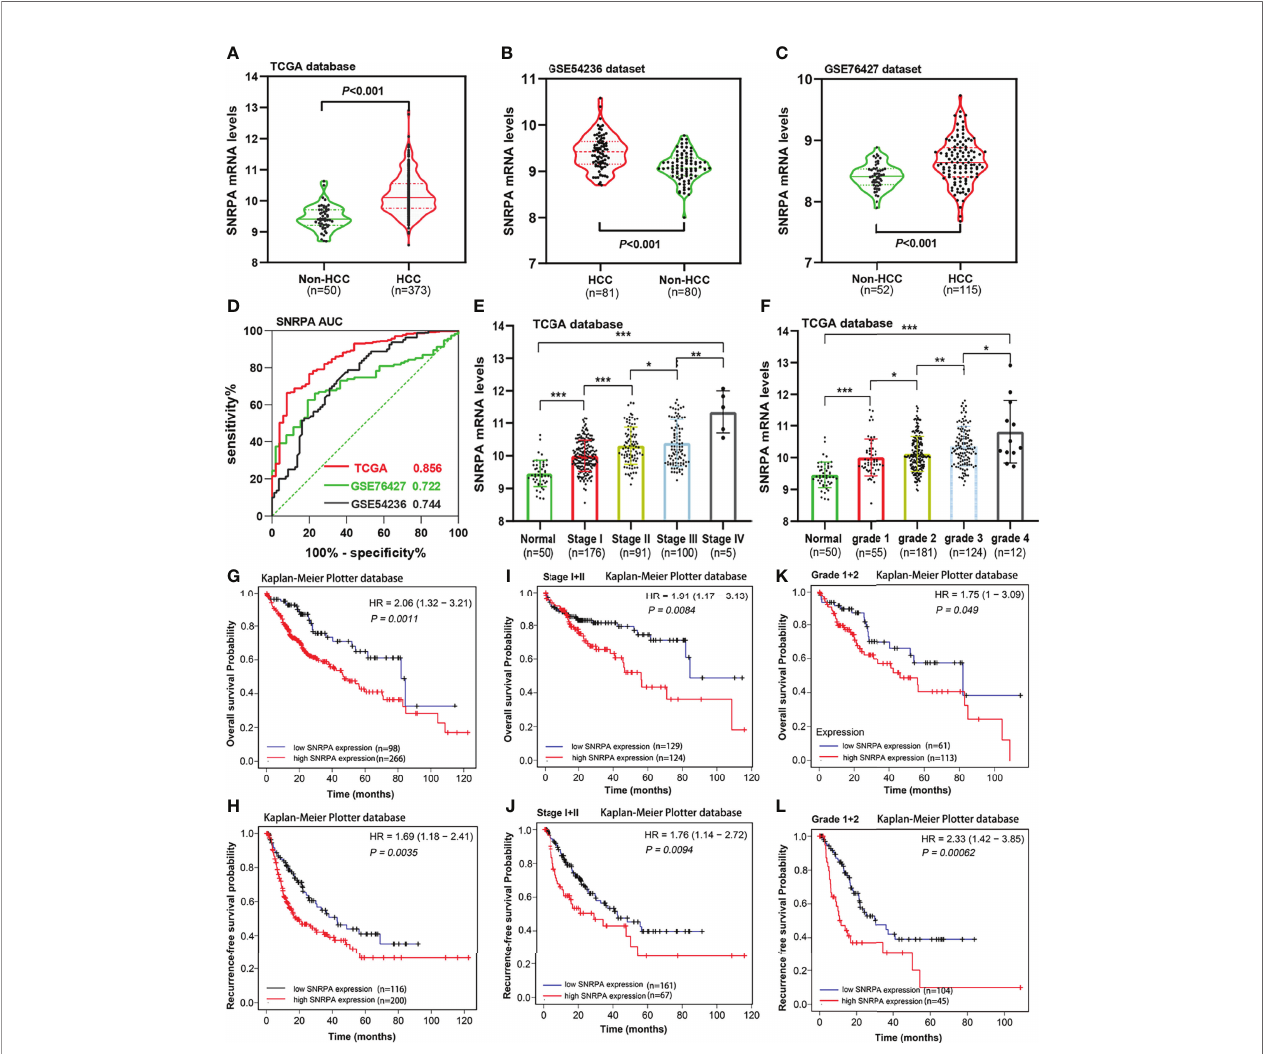
FIGURE 1 | SNRPA mRNA levels in HCC and adjacent normal liver tissues and its prognostic value. (A – C) SNRPA mRNA levels were signi fi cantly greater in HCC than in normal liver tissues in the TCGA (A) , GSE54236 (B) and GSE76427 (C) datasets. (D) ROC curve exhibited the excellent diagnostic value of SNRPA mRNA for HCC in TCGA and GEO databases. (E, F) The SNRPA mRNA expression gradually increased with the tumor stage (E) and tumor grade (F) increased. (G, H) Higher SNRPA mRNA expression was associated with worse OS (G) and RFS (H) . (I, J) In patients with stage I+II, higher SNRPA mRNA levels correlated with poor OS (I) and RFS (J) . (K, L) In patients with grade 1 + 2, higher SNRPA mRNA levels correlated with poor OS (K) and RFS (L) . * P < 0.05, ** P < 0.01, *** P <